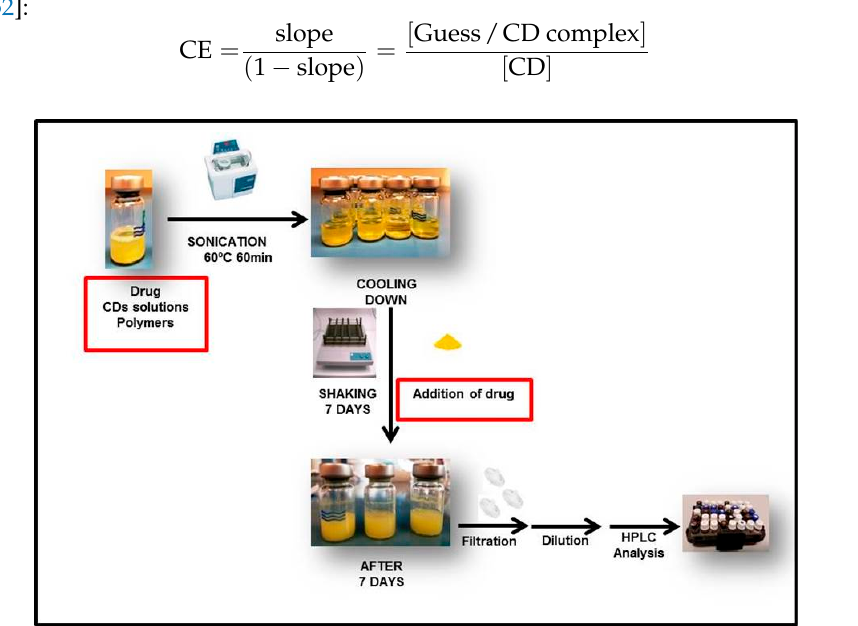
Figure 1. Schematic representation describing the steps involved in the formation of drug/CD inclusion complexes in phase solubility studies.